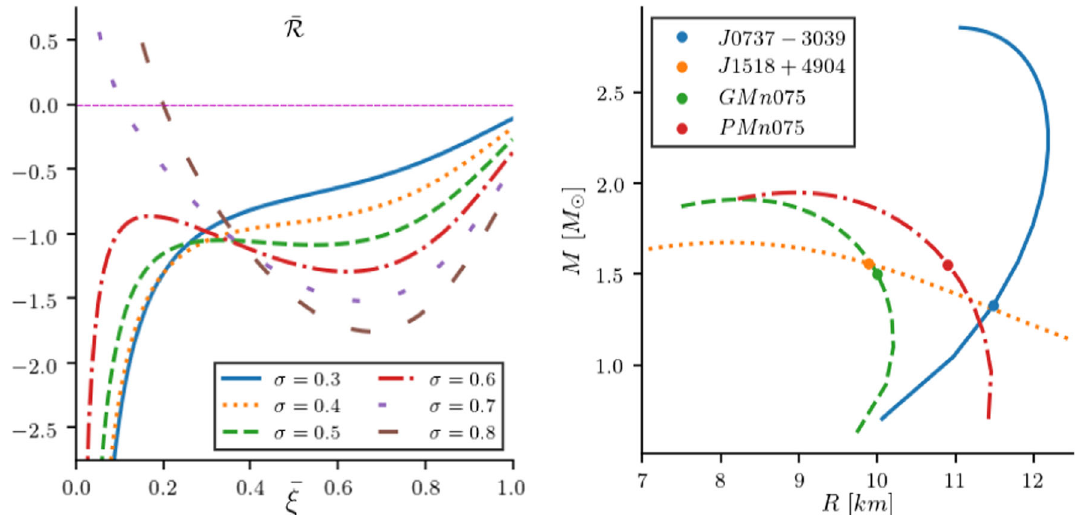
condition C6 (see Fig. 4 bottom plates). Right: M − R (total mass-total radius) curves for NS candidates in Table 1. Central density increases from right to left along the curve. All candidates are in the stable region models (to the right of the maximum